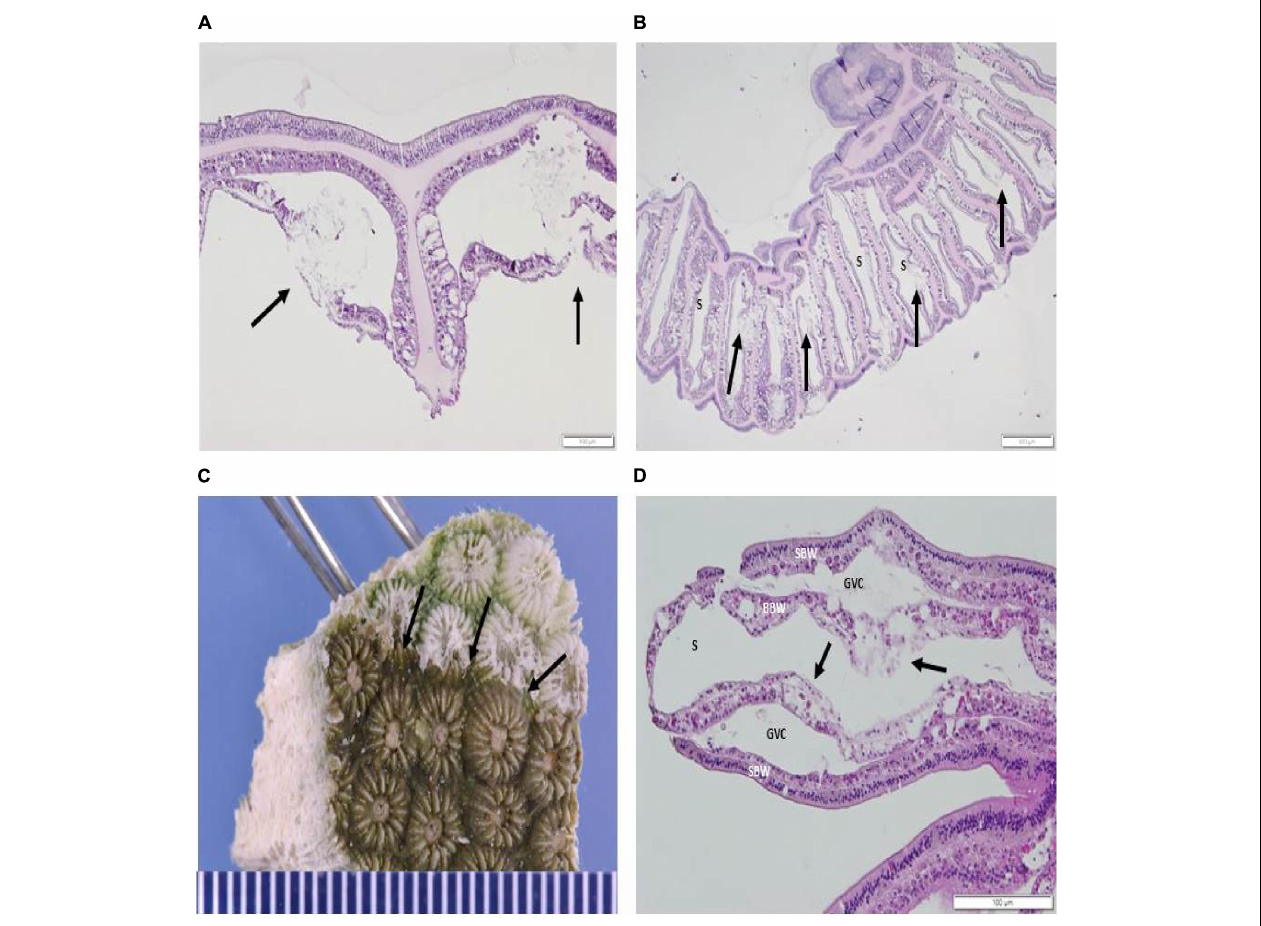
FIGURE 6 | (A,B) Histopathology of M. cavernosa recipient fragment showing induced LN lesions (H&E). (A) Sagittal section of the coenenchyme showing two LN lesions (arrows) after 2 days exposure initiating in the basal body wall (BBW). (B) Radial section across the oral area showing LN lesions in the septa (arrows) adjacent to the skeleton (S) initiating in the BBW, 10 days post experimental start. (C,D) Induction of tissue loss in the M. cavernosa to O. faveolata induction experiment. (C) Gross appearance of tissue loss in an AH O. faveolata recipient fragment after 7 days exposure to a D1fragment. Tissue loss border shown at arrows. (D) Histopathology of O. faveolata recipient fragment [seen in (C) ] in tangential section showing induced LN lesions in the BBW. Note deformed zooxanthellae, BBW necrosis, loss of architecture and vacuolation of the BBW gastrodermis (arrows). BBW, basal body wall; GVC, gastrovascular canal; SBW, surface body wall; S, skeleton